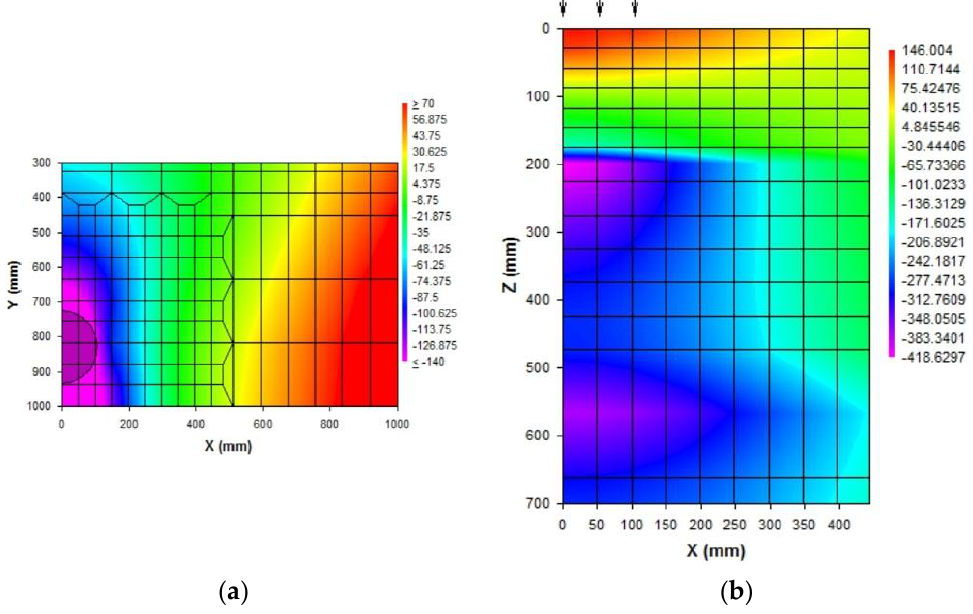
Figure 11. Contour plot of 5% CBR. ( a ) Horizontal strains, 10 MSA; ( b ) vertical strains, 10 MSA.